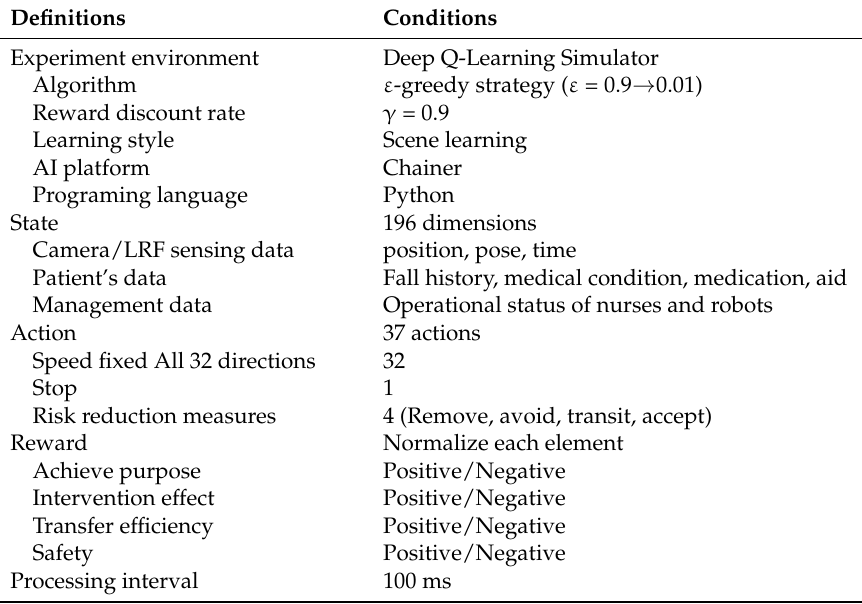
Table 2. Conditions for deep reinforcement learning.